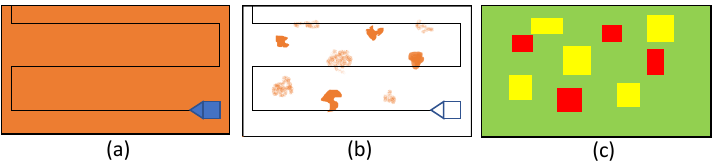
Figure 1. The overall sequence of the application context of the proposed robotic system. ( a ) Blasting robot is sent in a zig-zag path for uniformly blasting the area; ( b ) The benchmarking robot is sent in the previously blasted area to benchmark the blasting quality; ( c ) The benchmarking map that represents the quality of blasting in different areas.